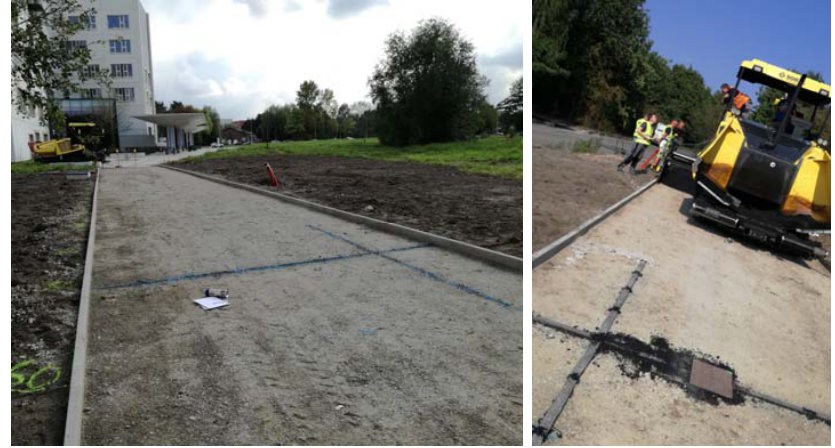
Figure 5. Installation of FBGs in the base asphalt layer directly on the base (first approach).